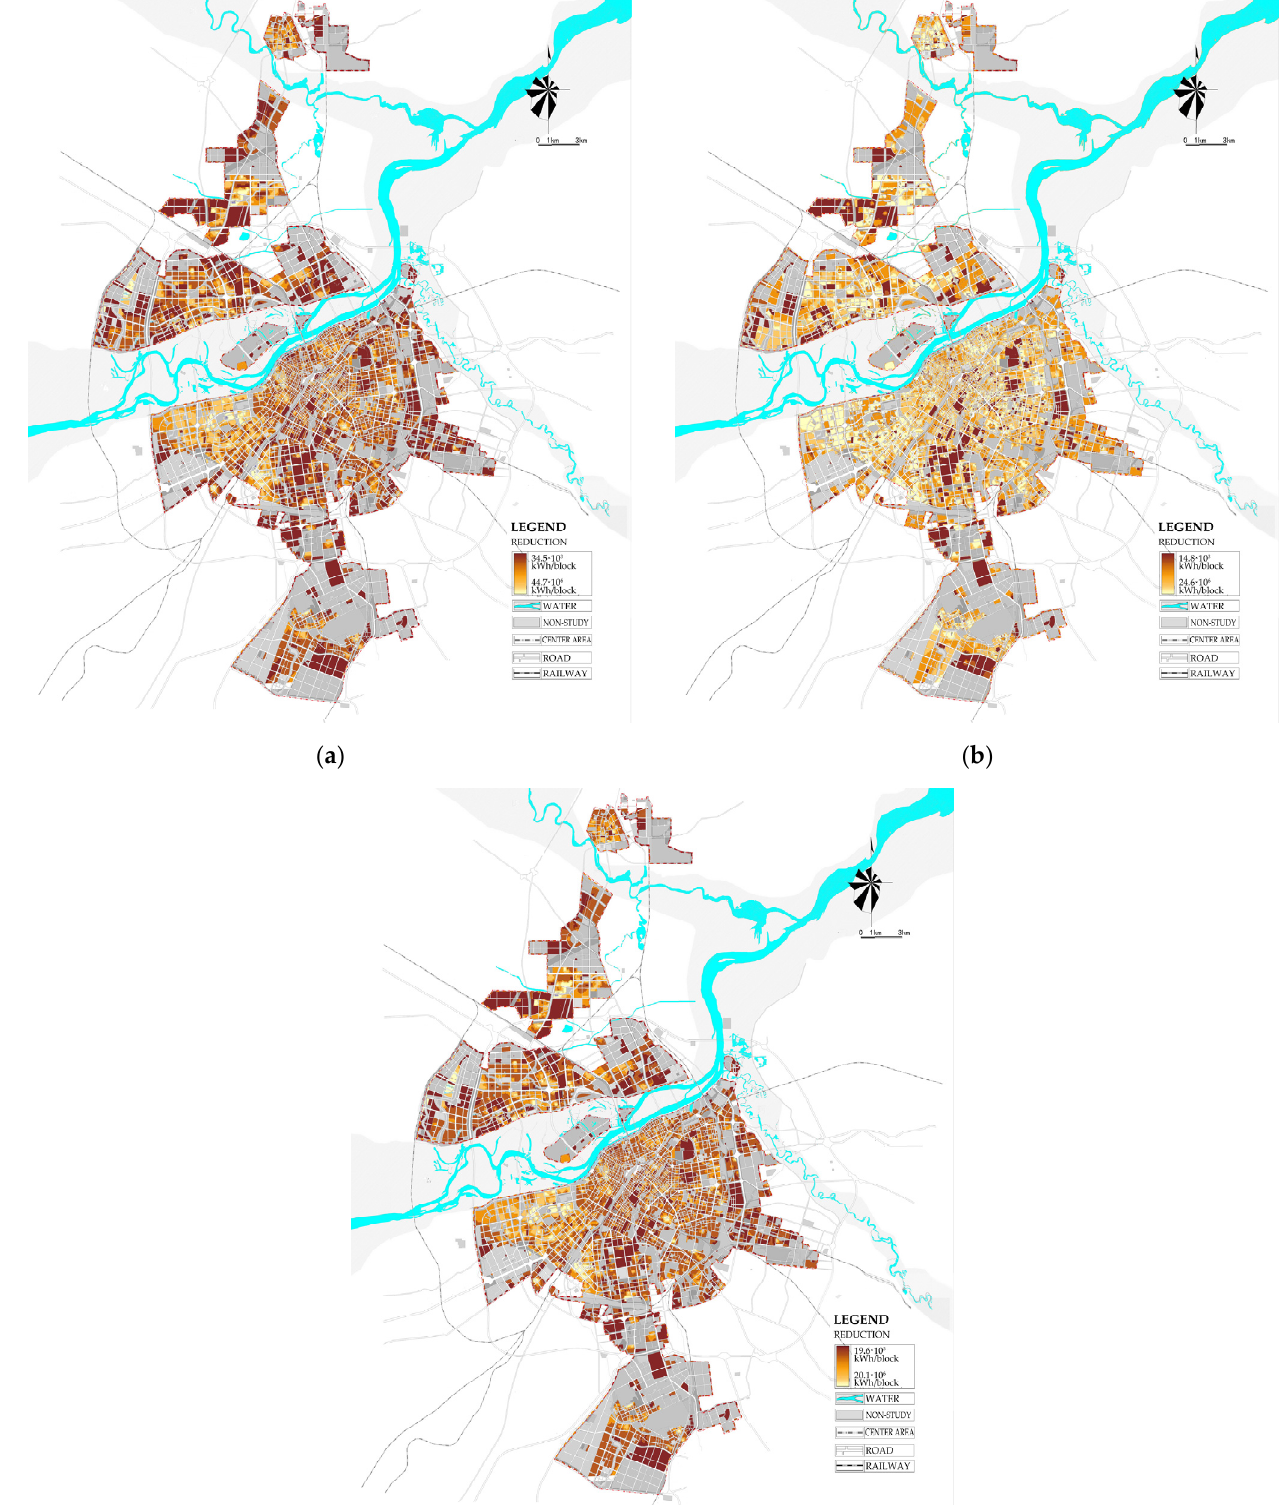
Figure 12. Annual reduction in building energy consumption of the central urban area under urban form scenario. ( a ) Total energy consumption; ( b ) electricity consumption; ( c ) heating energy consumption. Note: The term block refers to the grids mentioned in Section 2.2.2, and the area of each block is about 105 m 2 .